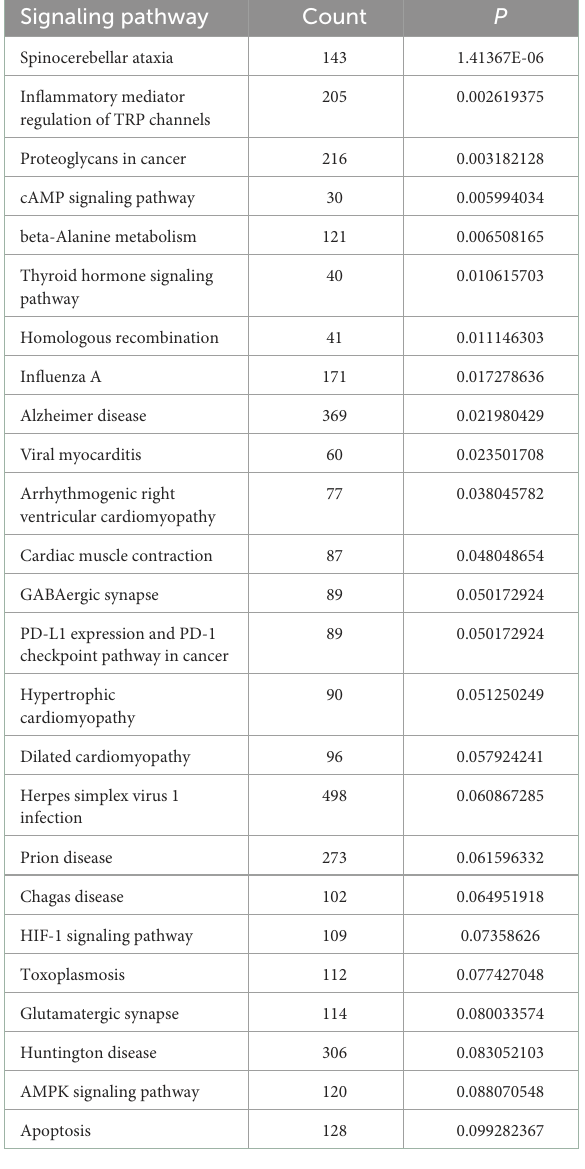
TABLE 4 The top 25 KEGG pathways related to circRNA after TBI. TABLE 5 Predicted miRNAs for the selected significantly differential circRNAs in